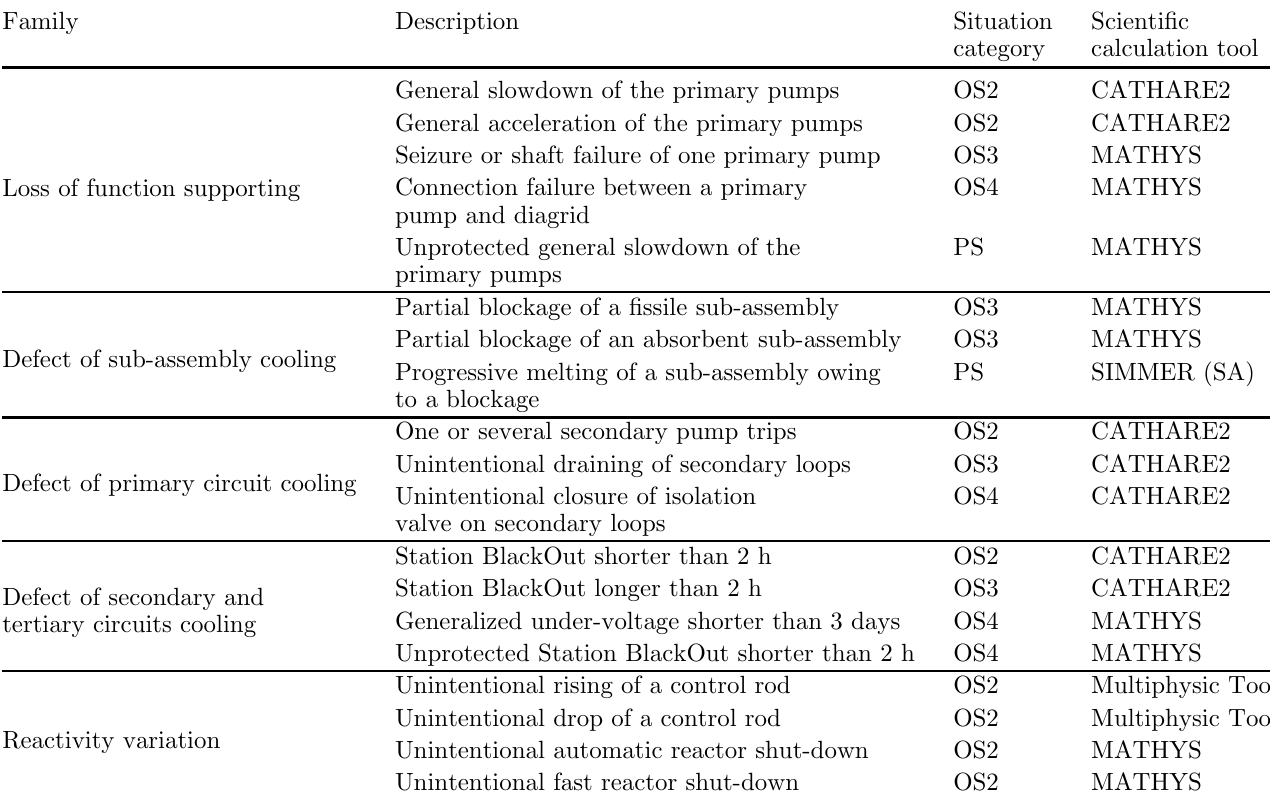
Table 1. 19 transients selected for this SFR safety demonstration (SA: Severe Accident). Family